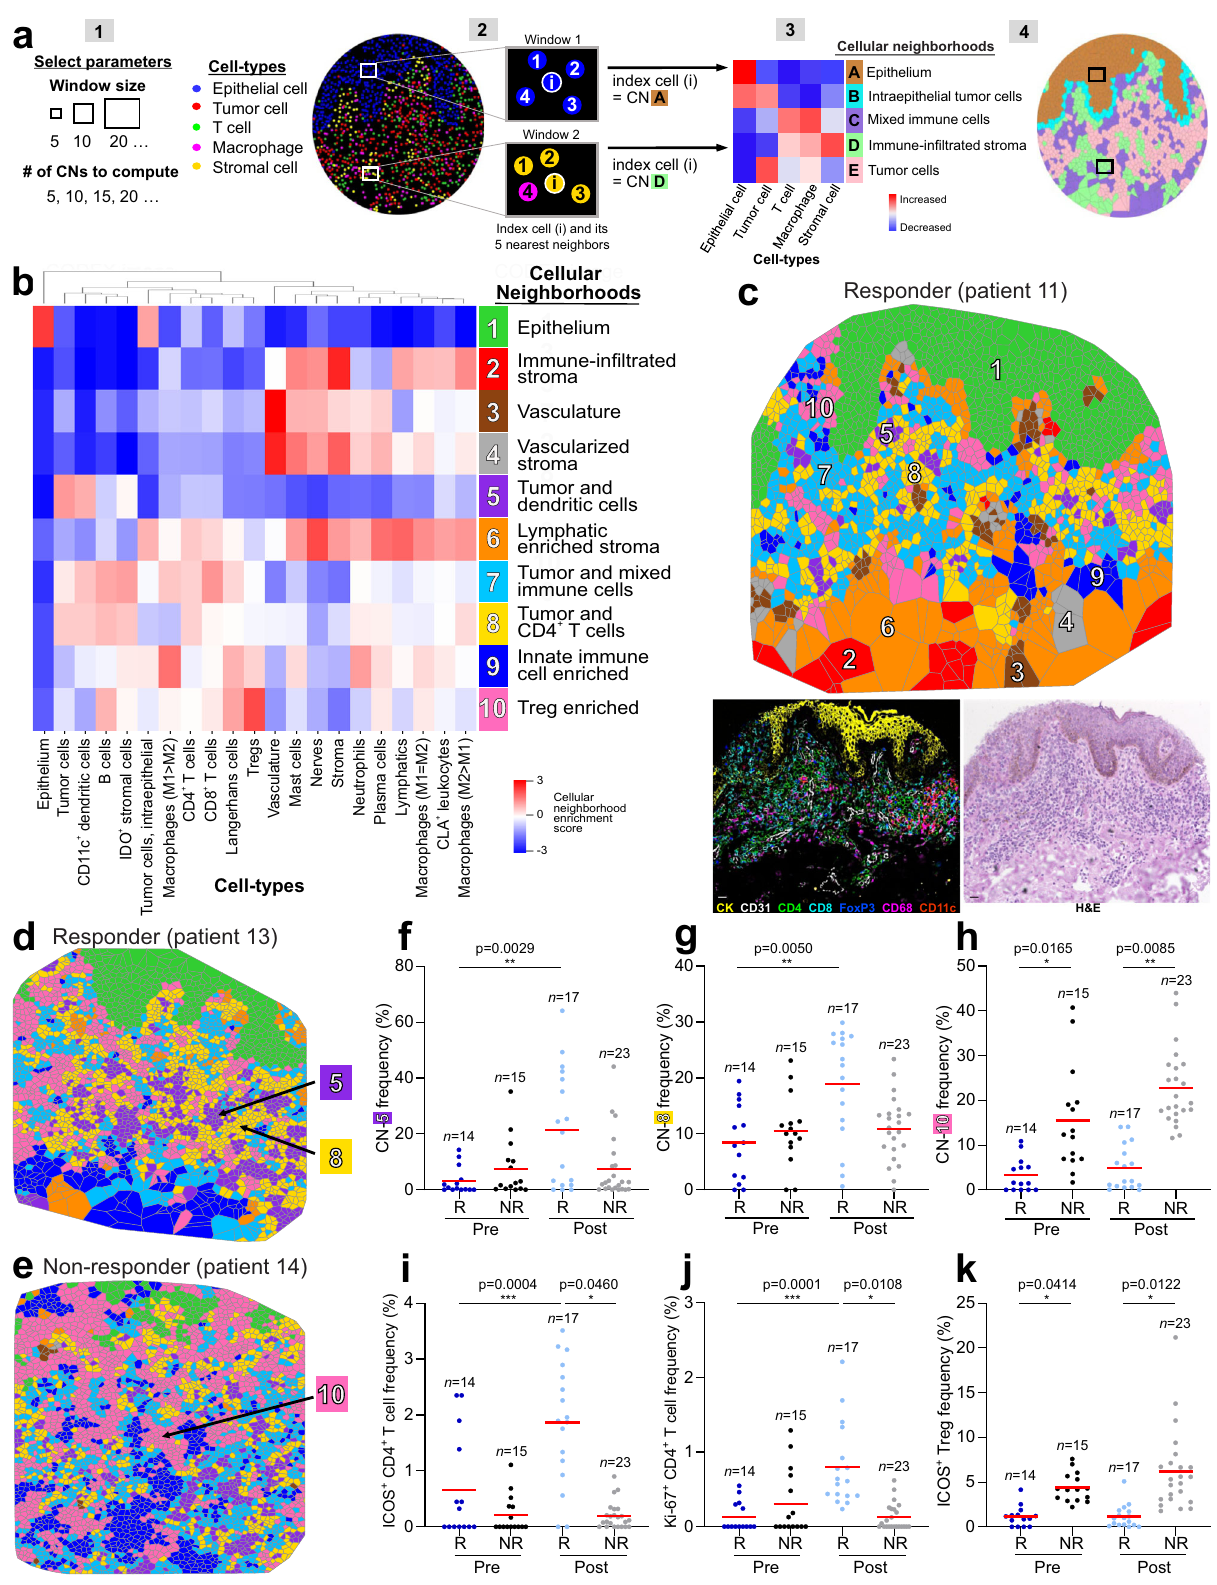
active process speci fi cally coordinates the spatial interactions of PD-1 + CD4 + T cells, tumor cells, and Tregs in responders. Finally, when the SpatialScore was calculated for CD8 + T cells (Supple- mentary Fig. 4e) and PD-1 + CD8 + T cells (Supplementary Fig.